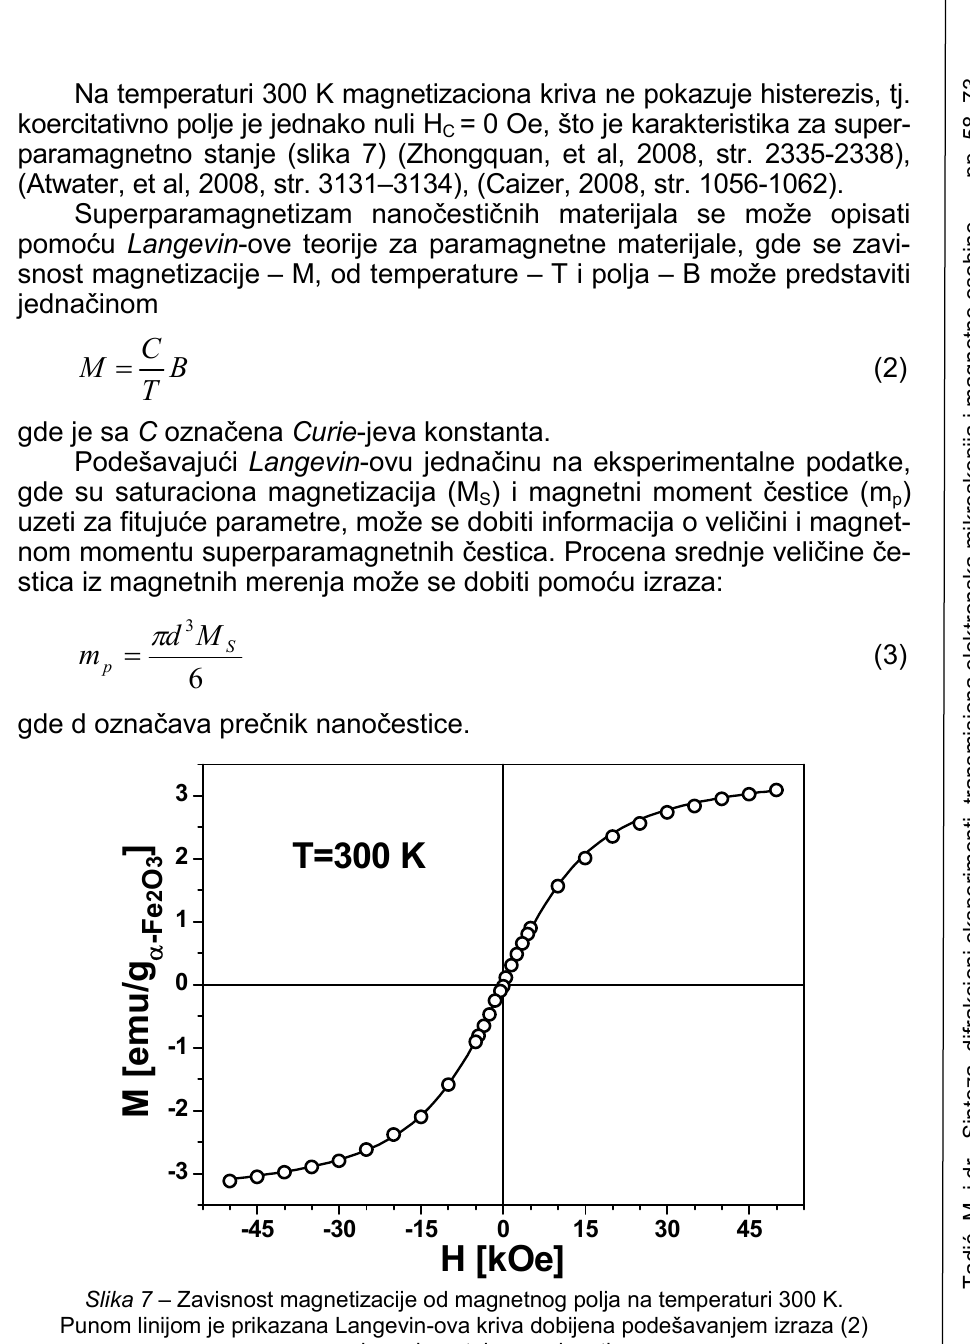
Punom linijom je prikazana Langevin-ova kriva dobijena podešavanjem izraza (2) na eksperimentalne vrednosti Figure 7 – Weighted Langevin function fit (full line) to the M(H) data (dots) measured at 300